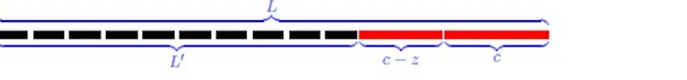
Fig 5. Circle approximation estimation method. The red solid turns (of lengths c and b = c − z ) are preserved; the black broken ones (of combined length L 0 ) are to be reconstructed.